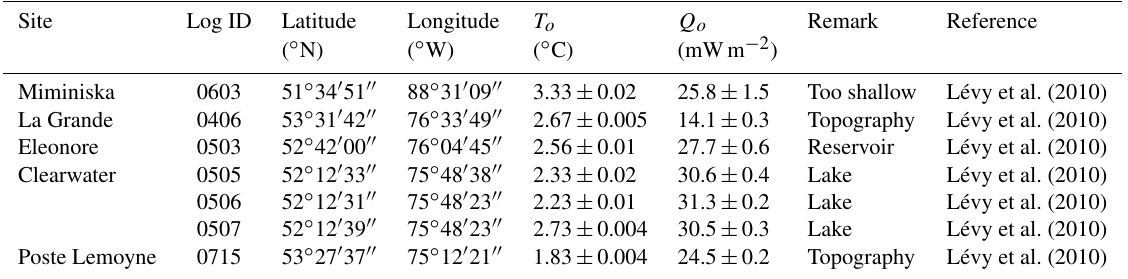
Table 2. Location and technical information concerning boreholes not suitable for this study, where T o is the reference surface temperature and Q o is the reference heat flux